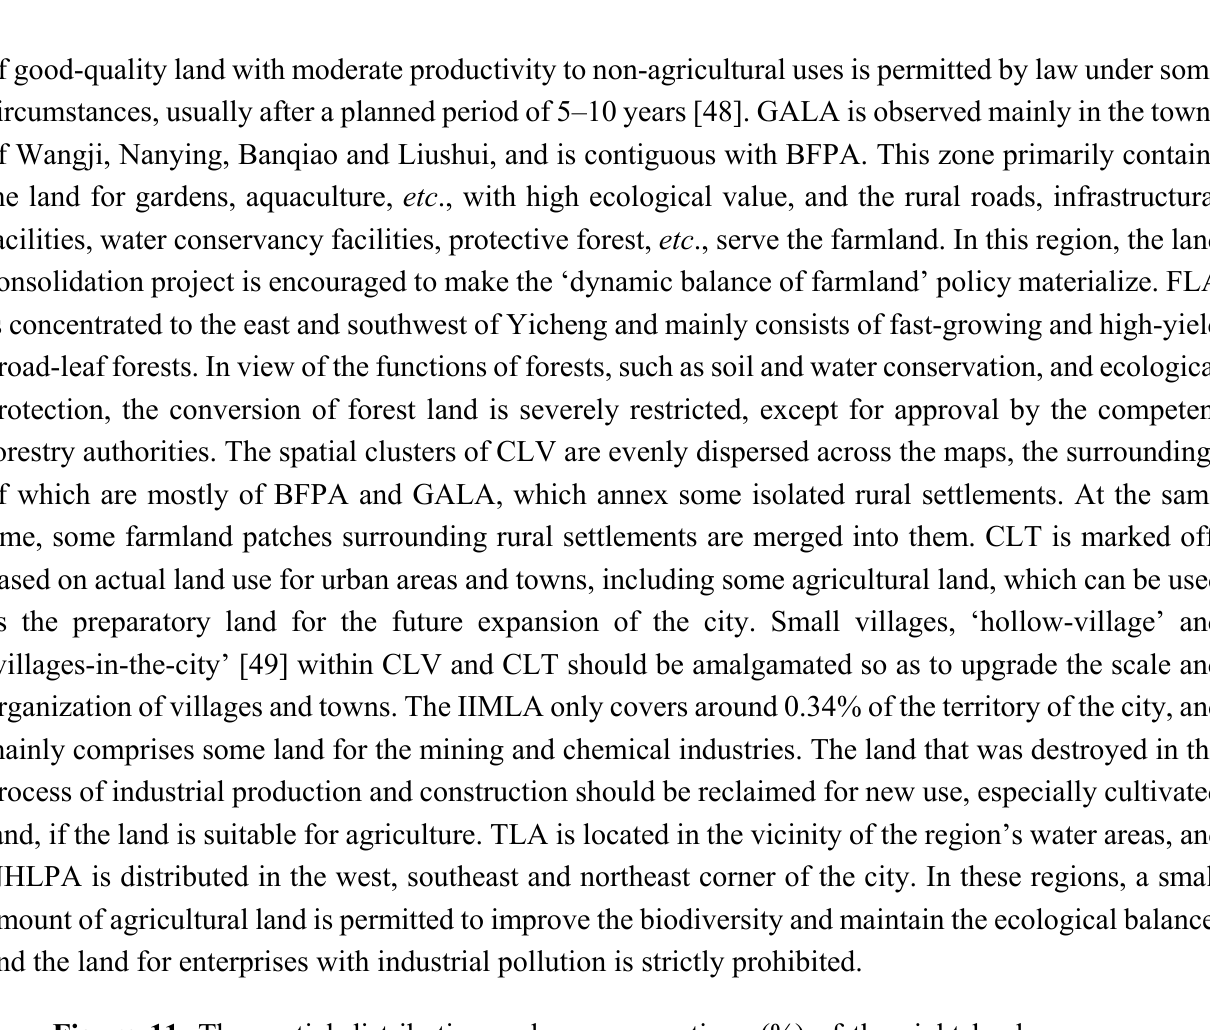
Figure 11. The spatial distribution and area proportions (%) of the eight land-use zones in Scenario